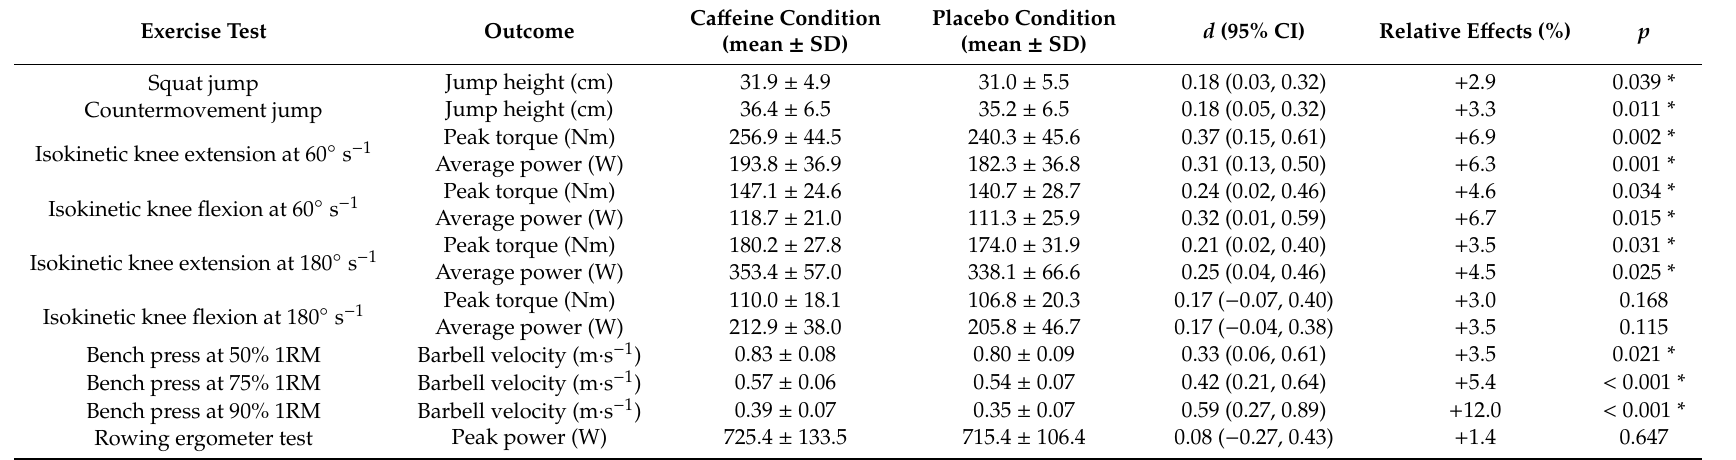
Table 2. Di ff erences in placebo vs ca ff eine conditions for the performance